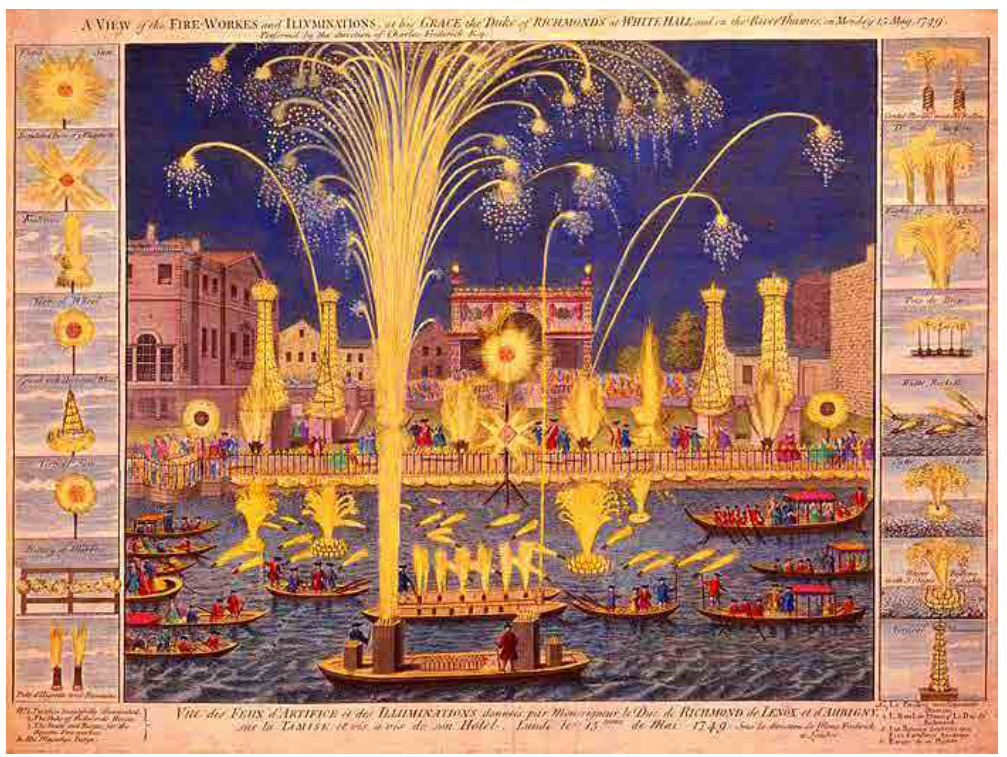
Fig. 7 Unknown, A View of